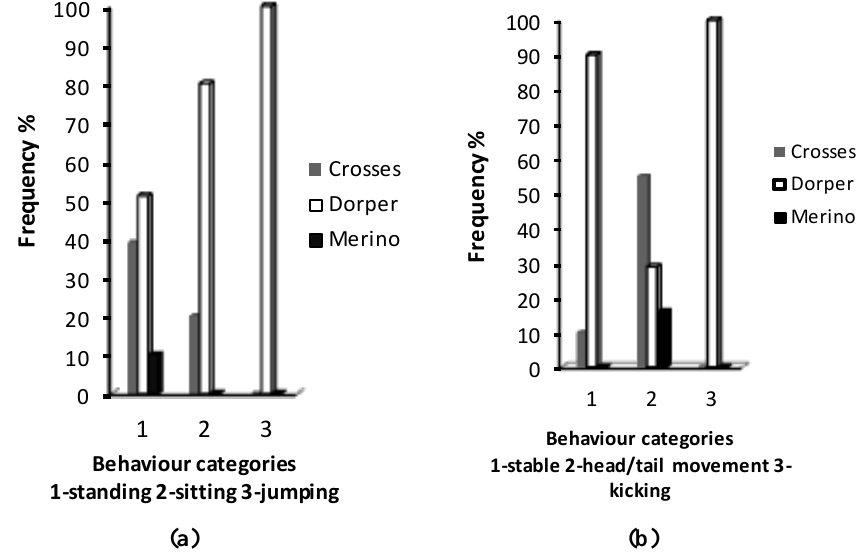
Figure 1. Frequencies of breeds in animal avoidance-related behaviour categories before stunning and during